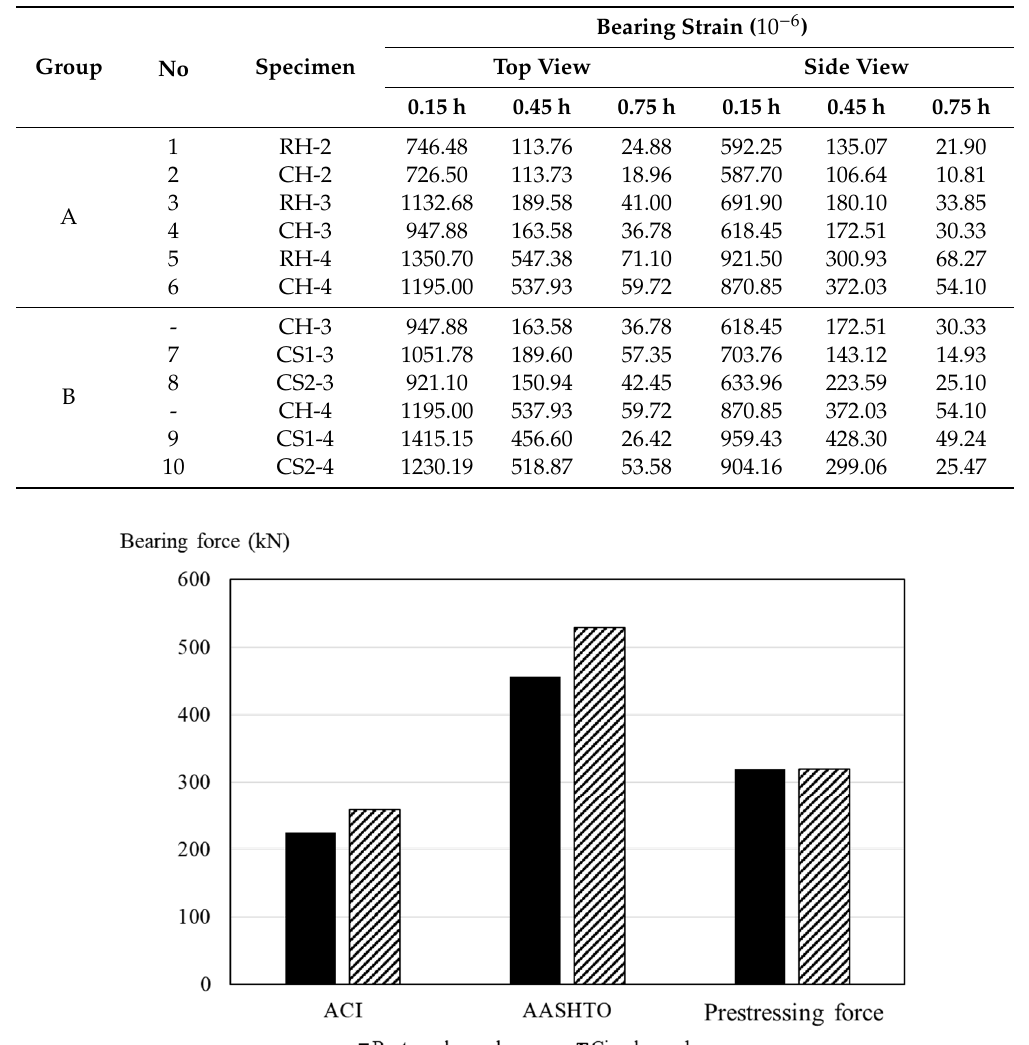
Table 3. Bearing strain at jacking force.